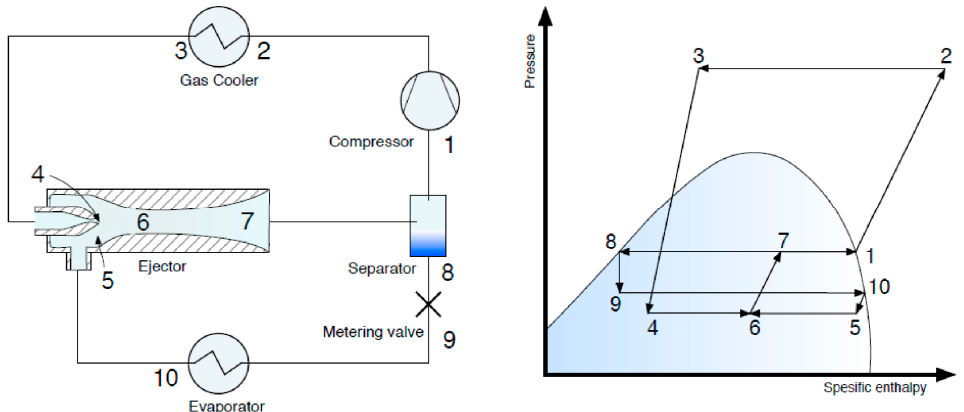
Figure 1. Schematic of a simple transcritical R744 vapor-compression system equipped with a two-phase ejector for expansion work recovery (left-hand side) and its p-h diagram (right-hand side) [13].